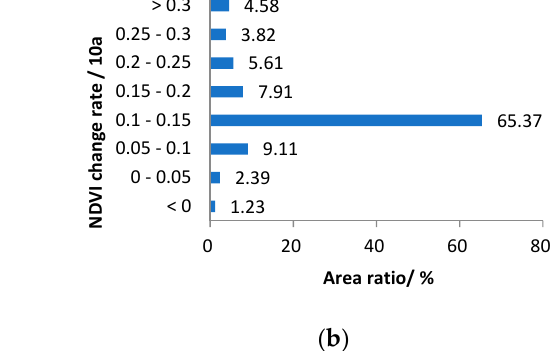
Figure 7. Change trend of NDVI in Qin Mountains (1981–2018).